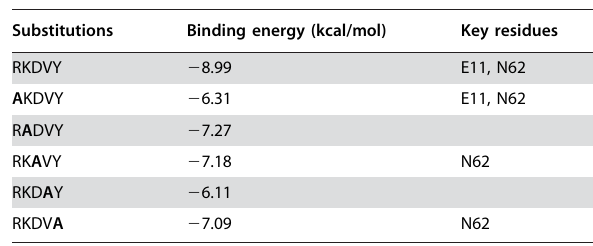
Table 2. The effect of alanine substitutions of TP5 on